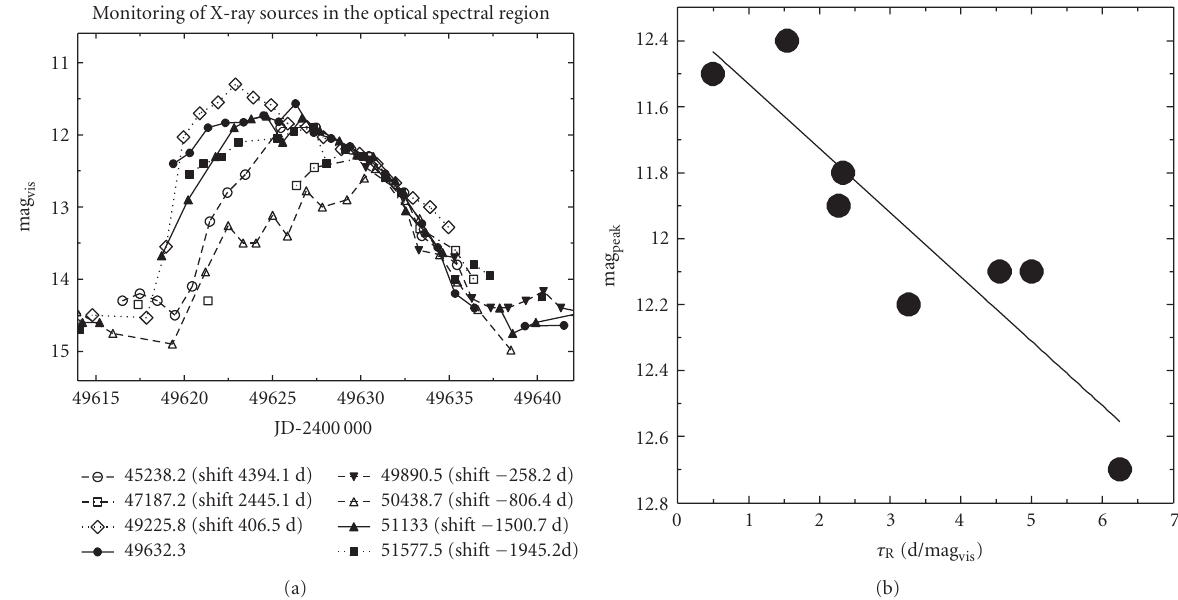
Figure 1: (a) Profiles of the outbursts in the dwarf nova DX And (observations from the AFOEV database). One-day means were connected by a line in densely covered parts for convenience. The individual outbursts were shifted along the time axis to match the decaying branch and the shifts with respect to the template are listed. (b) The relation between the peak of the template—the time of crossing 12.8mag vis of the outburst and the slope of its rising branch in DX And. The slope (rate of rise τ R ) is expressed in days mag − 1 magnitude mag peak Adapted from